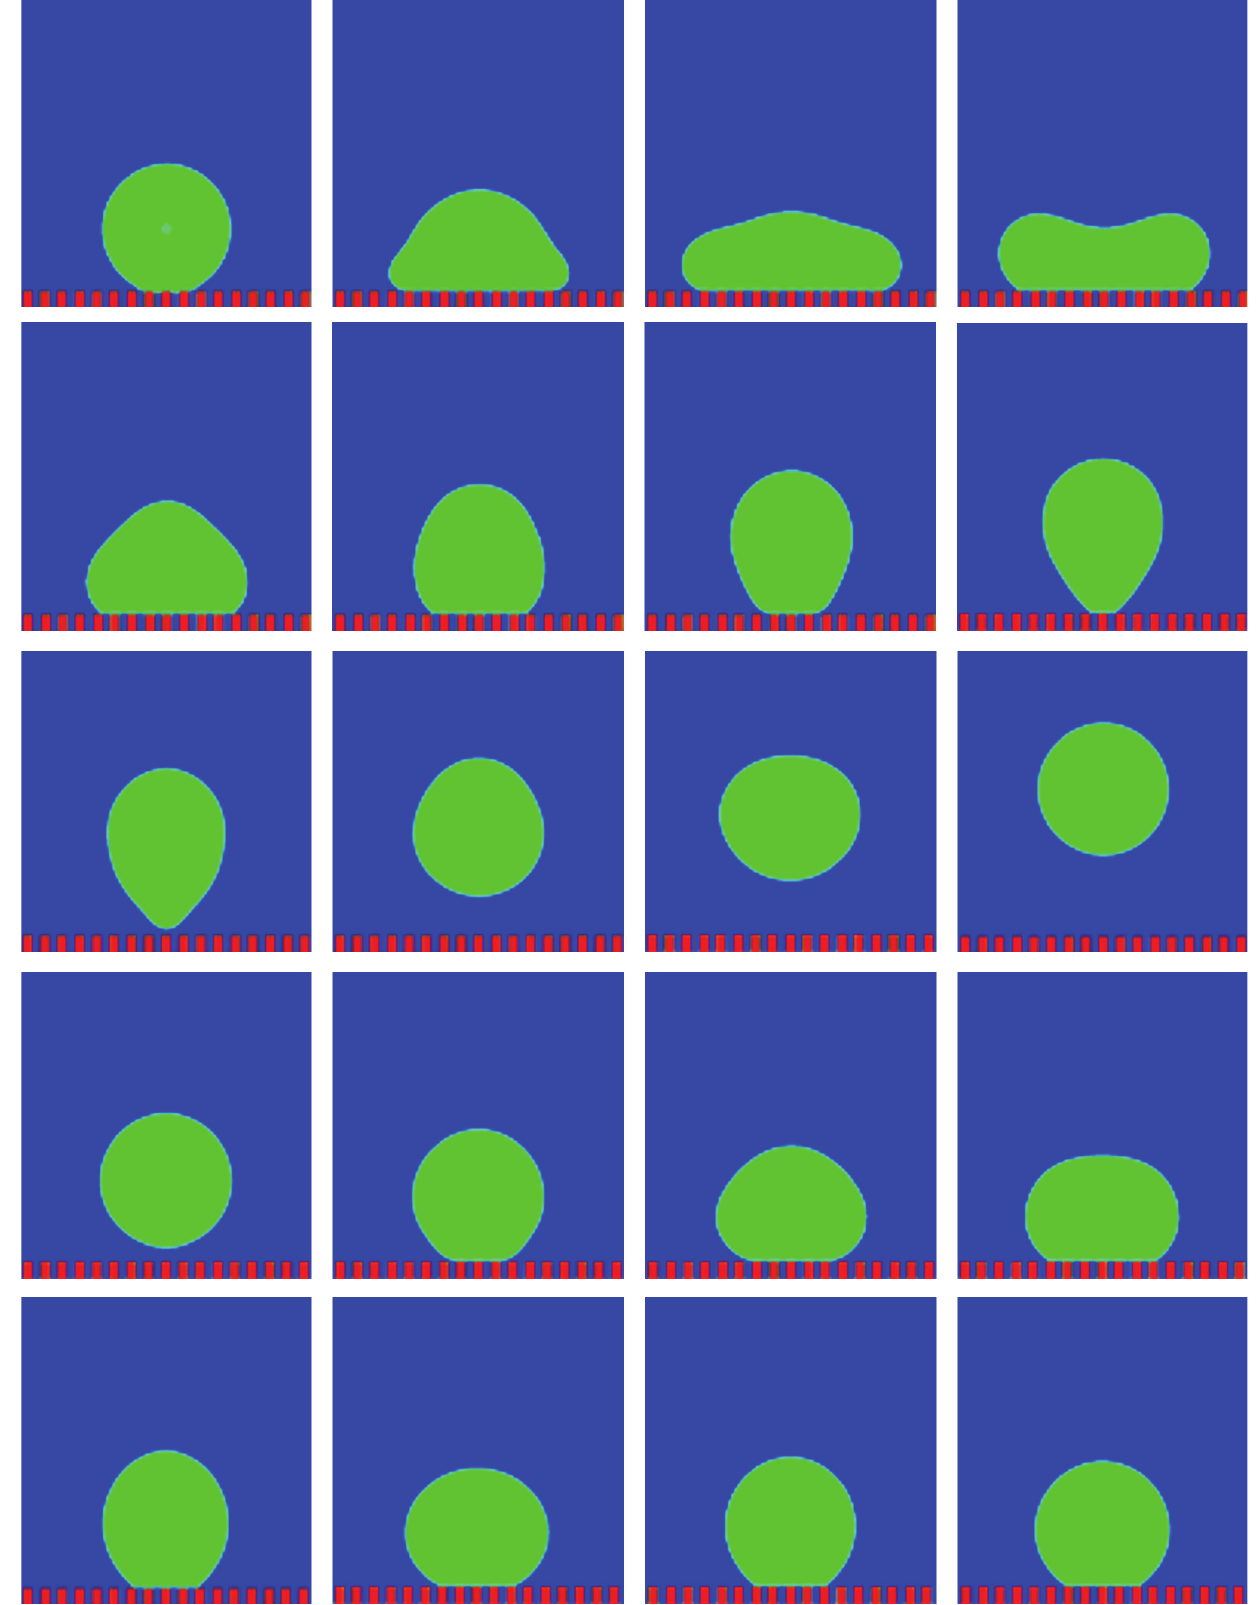
Figure 6: The dynamic behaviors of droplet impacting on hydrophobic surface (CA = 138.2 ∘